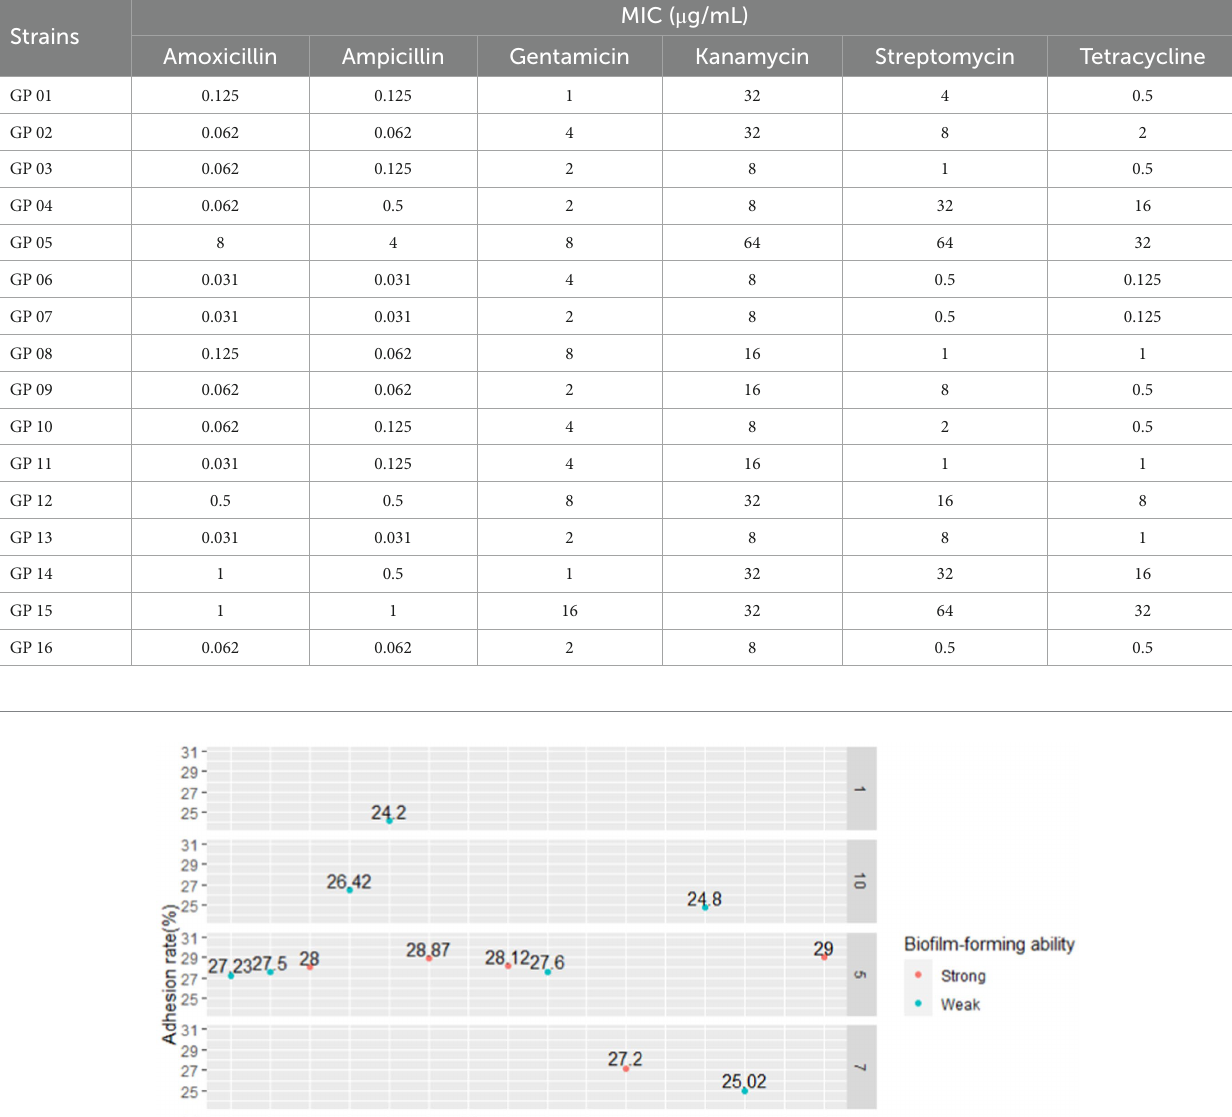
TABLE 10 Antibacterial activity test results.